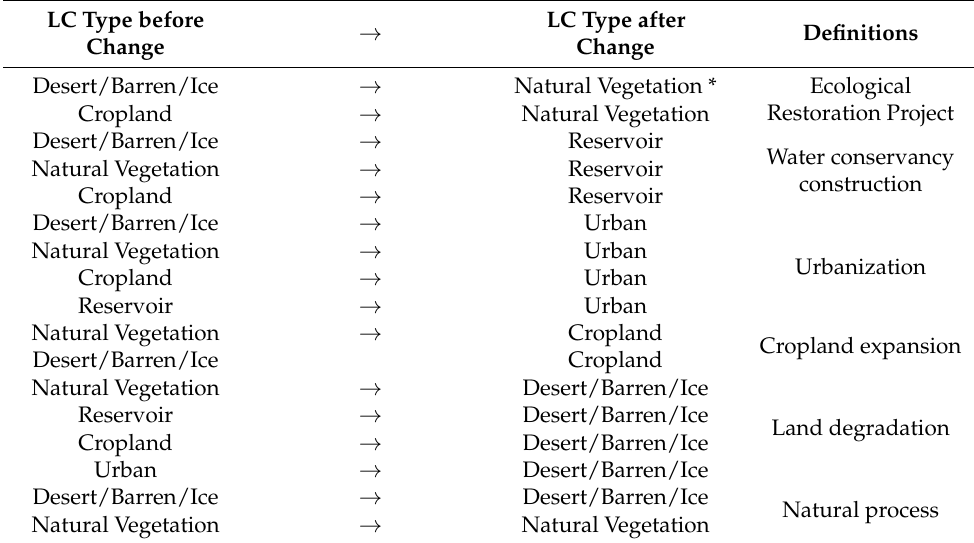
Table 1. Land cover or ecosystem transfer and change detection